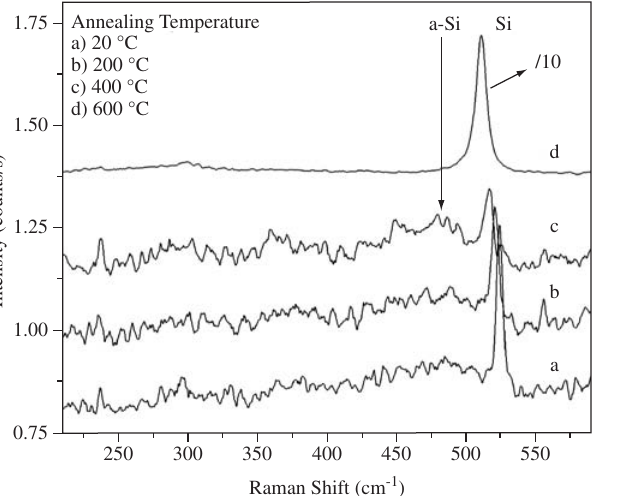
Figure 9. Raman spectra of the silicon (100): a) monocrystalline silicon after machining at room temperature of 20 °C; b) machined surface during annealing (200 °C); c) machined surface during annealing (400 °C); and d) machined surface during annealing (600 °C).